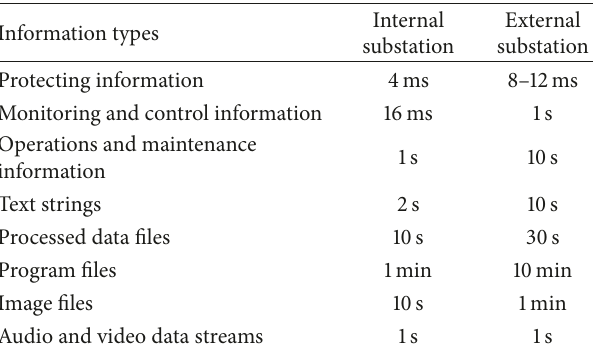
Table 1: Communication latency requirements for electric substa- tion automation